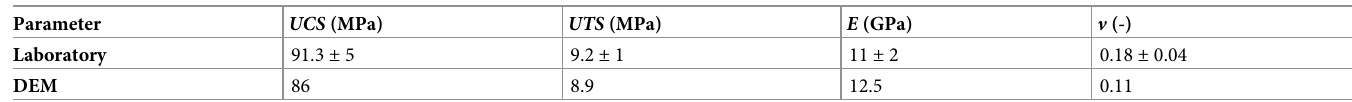
Table 1. Macro mechanical properties of andesite obtained from laboratory measurements and DEM simulations.